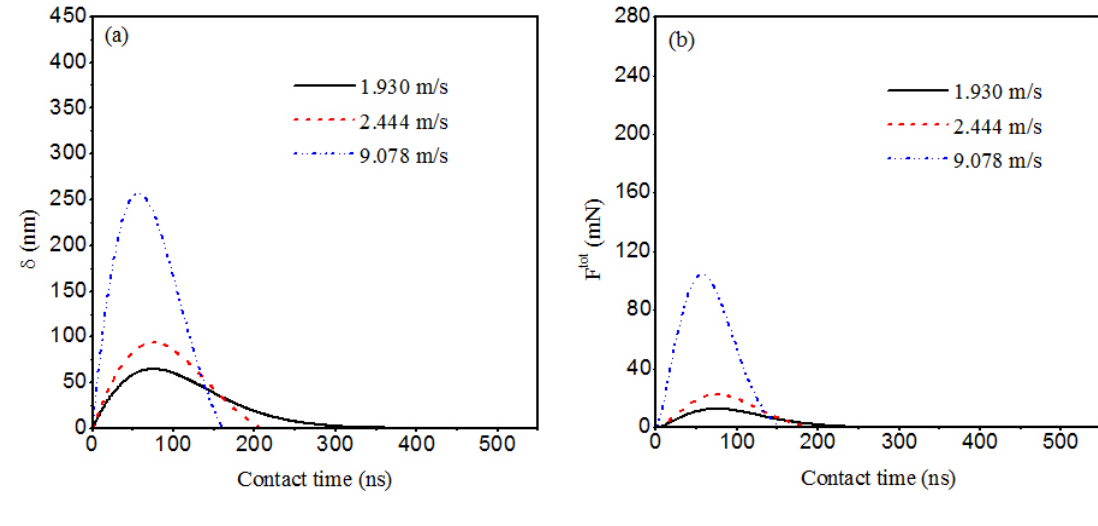
Figure 4. ( a ) The curves of overlap with contact time and ( b ) the curves of total force with contact